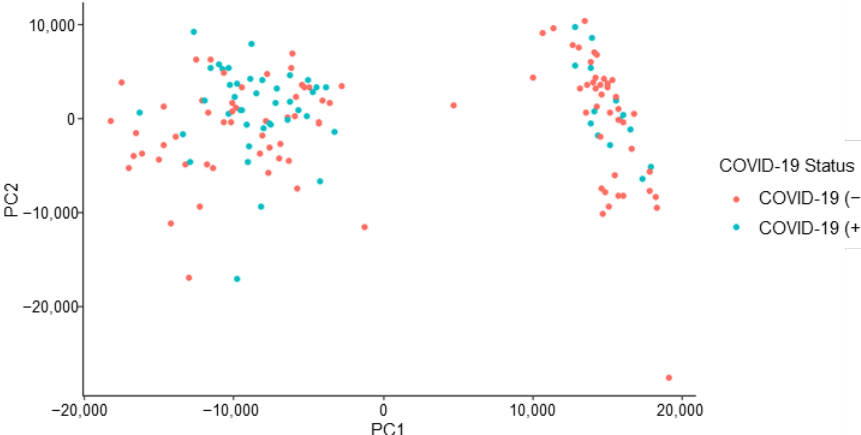
Figure 3. Initial COVID T-shirt PCA labelled by donor’s COVID-19 status.